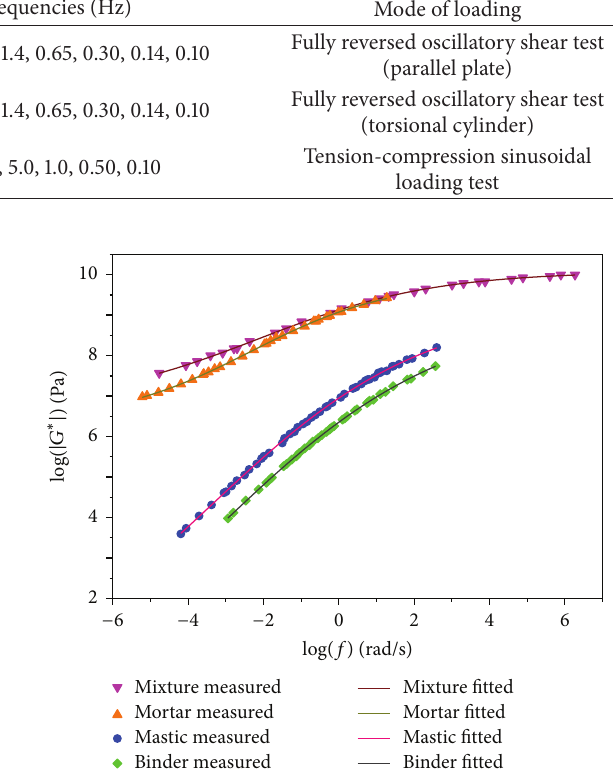
Figure 3: Experiment data and converted master curve of four